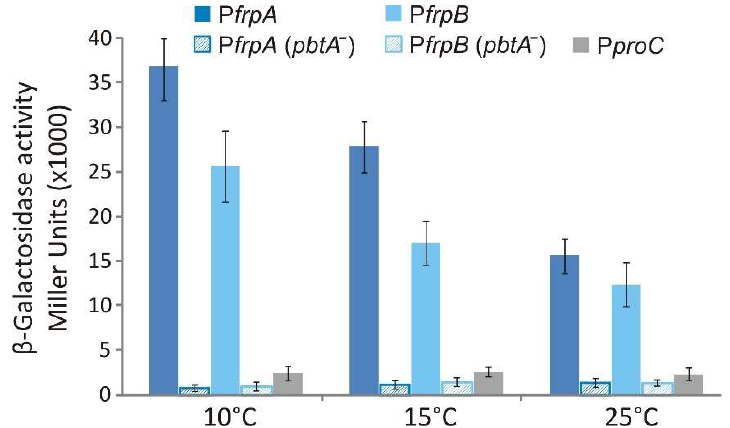
Figure 6. The transcriptional activity of promoters P frpA and P frpB at three different temperatures (10, 15 and 25 °C) measured in a V. anguillarum RV22 Δ vabF background (solid color bars) and in a V. anguillarum RV22 Δ vabF Δ pbtA background (striped bars). Constitutive promoter P proC was used as control.